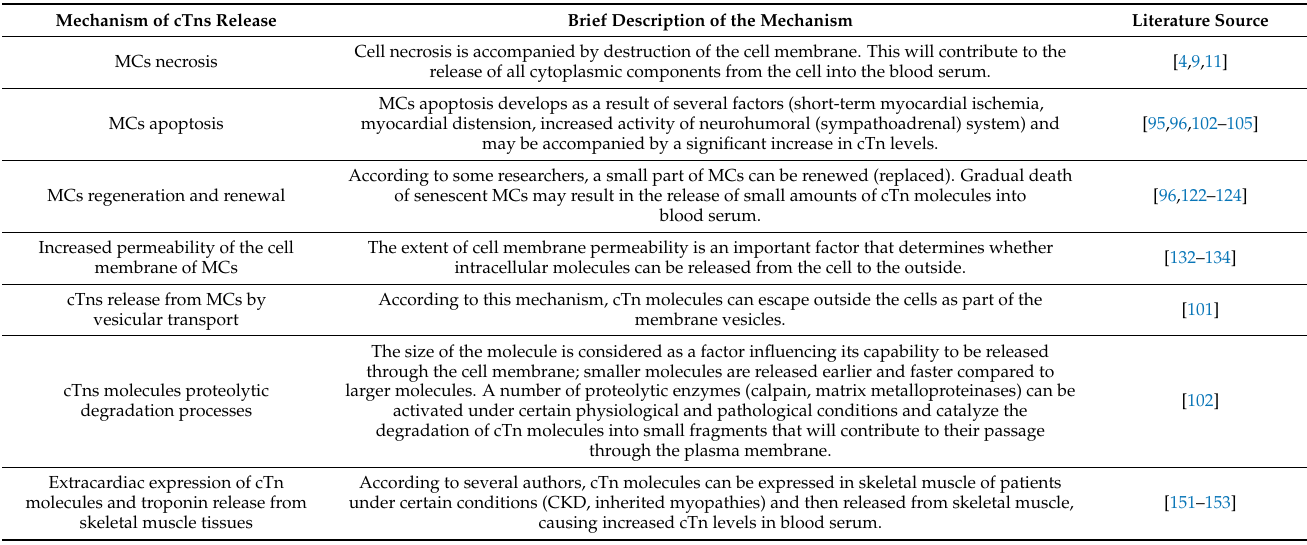
Table 2. Possible mechanisms of cTns release from